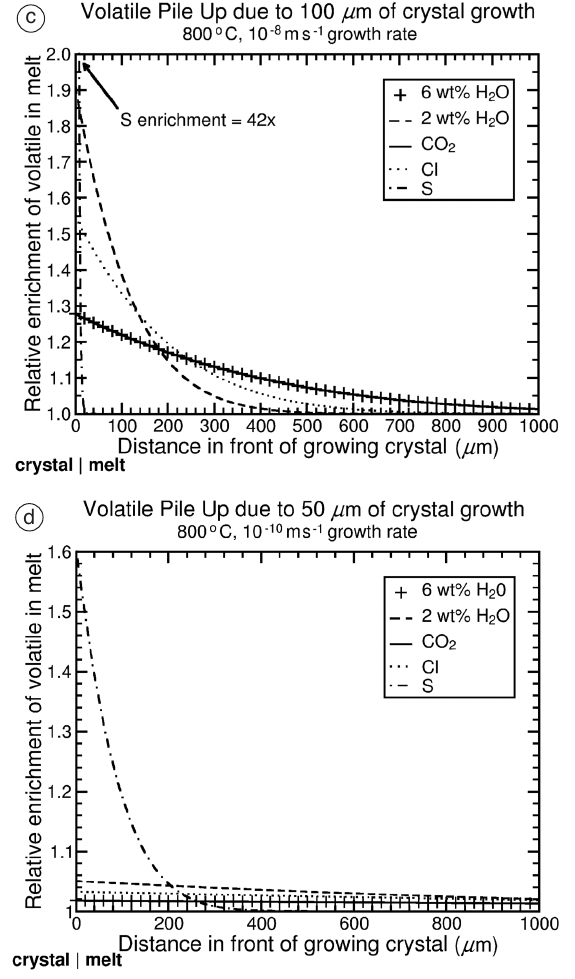
Fig. 7c,d. Volatile concentration enrichment profiles in front of a crystal growing in a rhyolitic melt at 800°C. The diffusion coefficients for volatiles are from fig. 5 and the sources of the crystal growth rates are discussed in the text. Note that composition enrichment profiles for 6 wt% H 2 O and CO 2 plot on top of one another because their diffu- sion coefficients are identical at the conditions studied (see fig. 5). The effects of crystal growth on volatile concen- tration enrichment profiles relative to the concentration at infinite distance near the crystal-melt interface are mod- elled at a growth rate of 10 − 8 ms − 1 for a total growth of 100 µ m (c). The volatile concentration enrichment profiles after 50 µ m of crystal growth at 10 − 10 ms − 1 are also modelled to demonstrate the effect of crystal growth rate on volatile enrichment (d). Further discussion is found in the